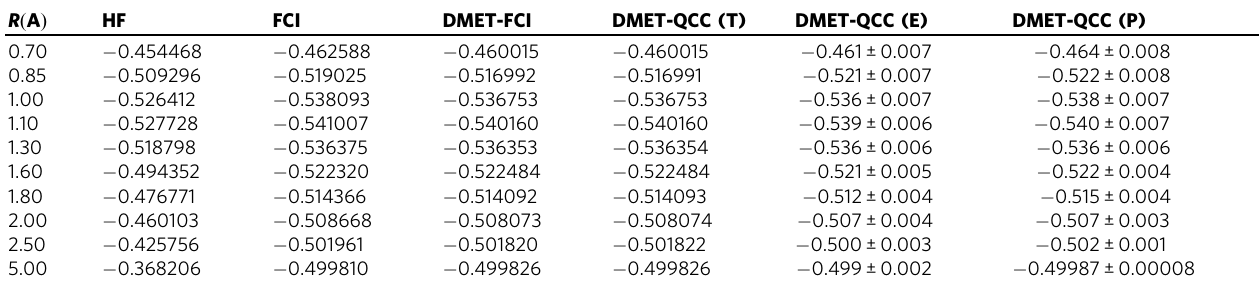
Table 1 Numerical and experimental values of the total energies per atom of the ring of ten hydrogen atoms (H 10